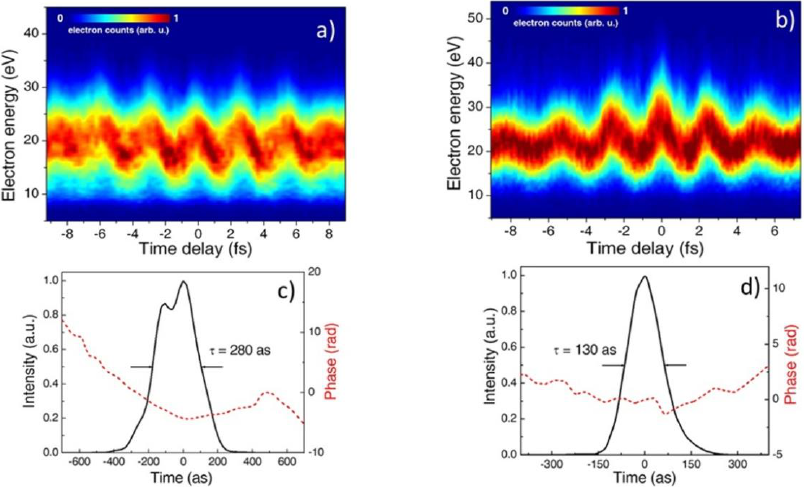
Figure 12. ( a ) Experimental Frequency Resolved Optical Gaiting for Complete Reconstruction of Attosecond Bursts (FROG-CRAB) traces for an isolated asec pulse generated by the polarization gating technique in Argon using an Al filter with a thickness of 100 nm ( a ) and 300 nm ( b ), respectively; ( c , d ) Reconstructed amplitudes (black solid lines) and phases (red dashed lines) for the experimental traces shown in ( a , b ), respectively. From Ref. [63].